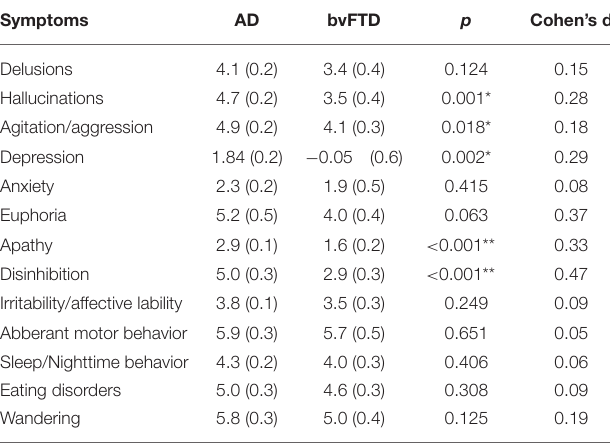
TABLE 4 | The BPSD onset in AD and bvFTD